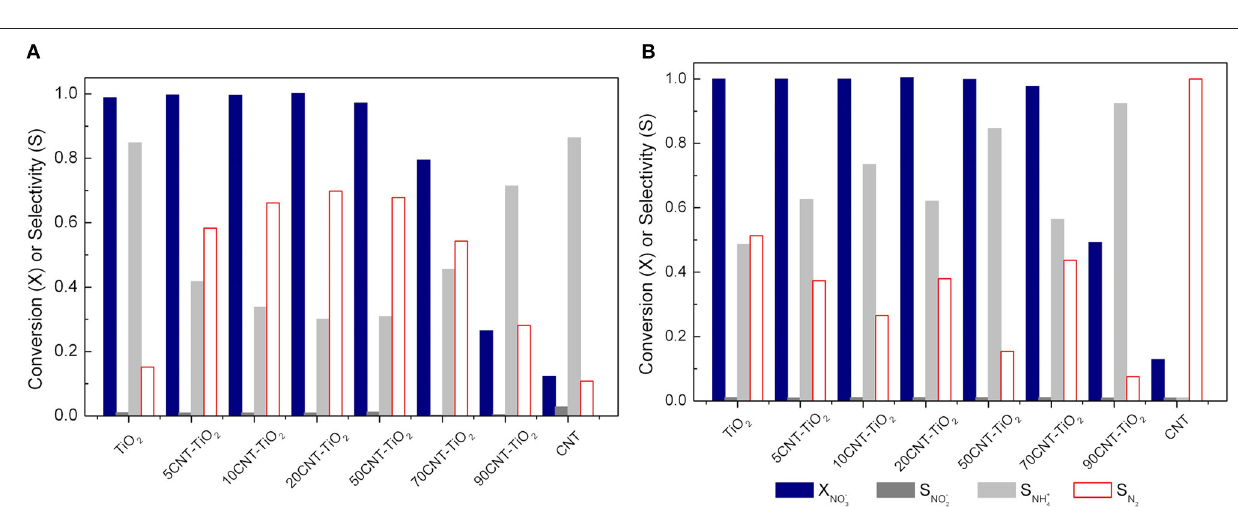
FIGURE 8 | Nitrate conversion ( X NO 4h of catalytic (A) and photocatalytic (B)